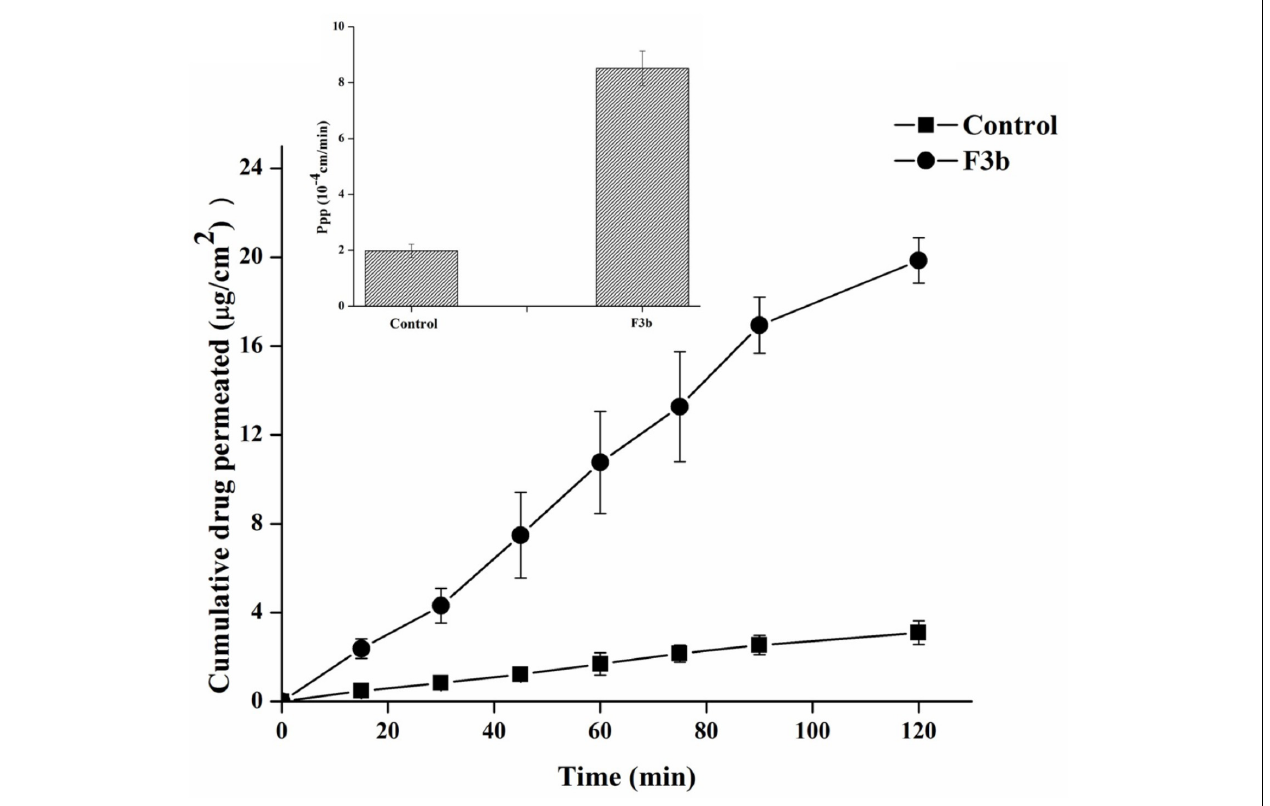
FIGURE 8 | Ex vivo permeation profiles and Papp of fenofibrate from raw dispersion and SNEDDS model formulation F3b using non-everted rat intestinal sac